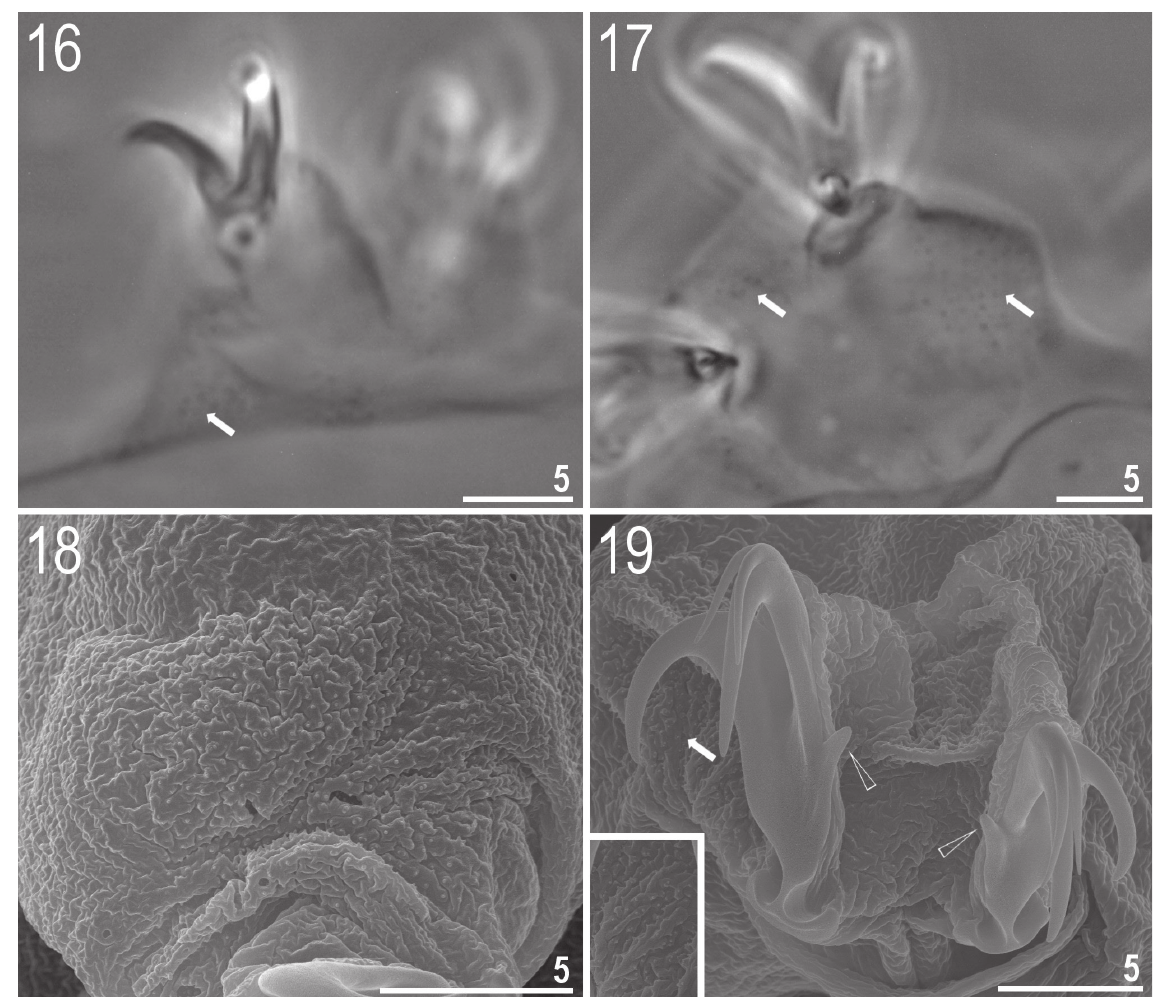
Figs 16–19. Macrobiotus polypiformis sp. nov., paratypes. 16 . Granulation on the II pair of legs, arrow (PCM). 17 . Granulation on IV pair of legs, arrow (PCM). 18 . Granulation on II pair of legs (SEM). 19 . Modified claw IV (arrowheads) and granulation on IV pair of legs, arrow (SEM). Scale bars in